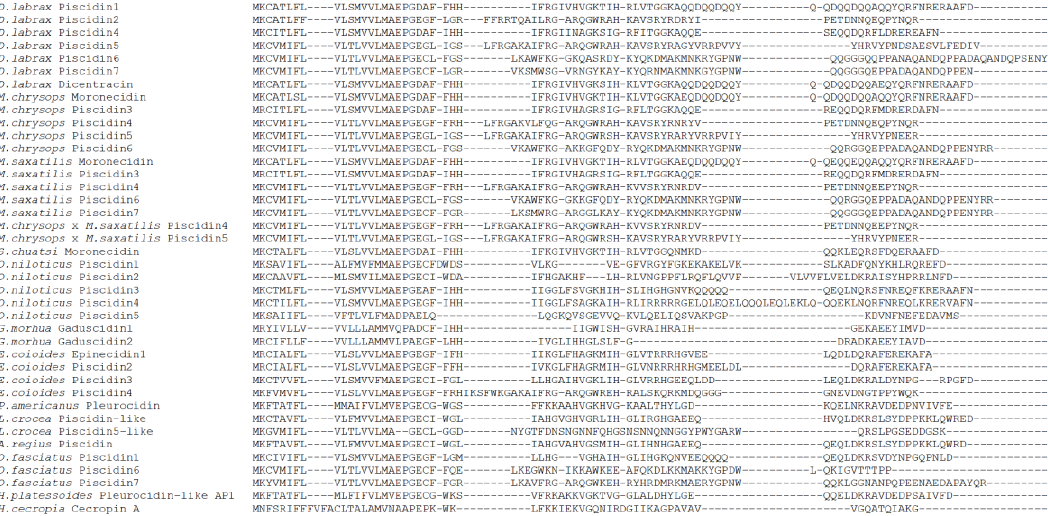
Figure 4. Alignment of sea bass piscidins with peptides from other fish species and with cecropin A from cecropia moth. Identical residues are denoted by (*), conserved substitutions by (:) and semi-conserved substitutions by (.).